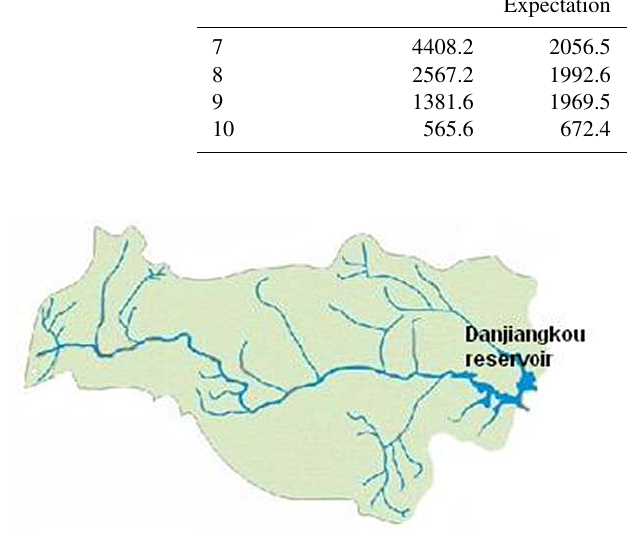
Figure 3. Basin area and river network of the Danjiangkou reser-